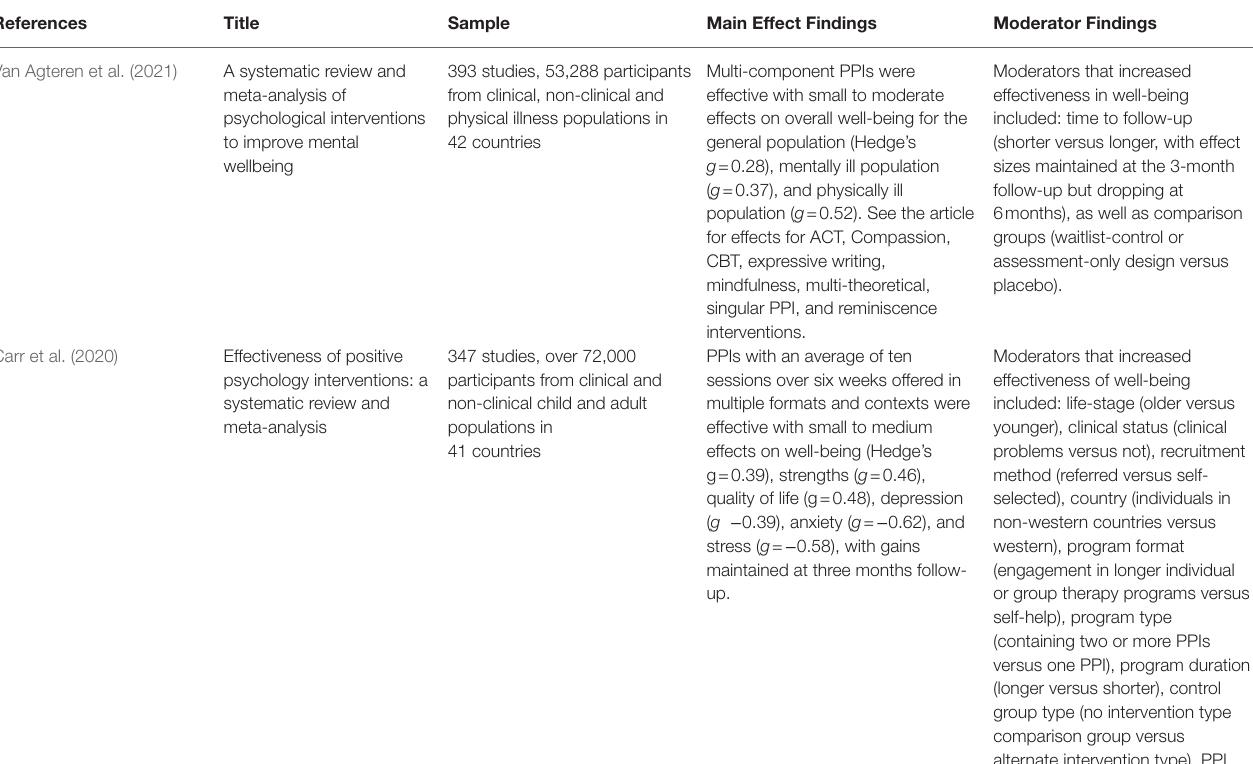
TABLE 1 | Positive psychology intervention